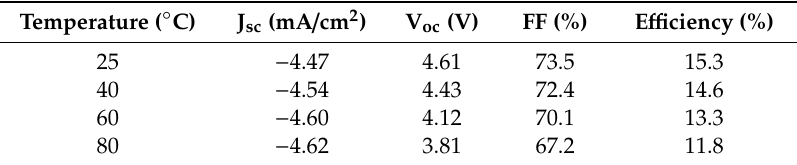
Figure 2. Evaluation of the temperature dependence of the solar cell efficiency: ( a ) J-V curves of the solar cell as a function of temperature; ( b ) time dependence of the J-V curves under AM 1.5 G illumination; ( c ) temperature dependence of the solar cell efficiency. Table 1. Temperature dependence of the solar cell performance.